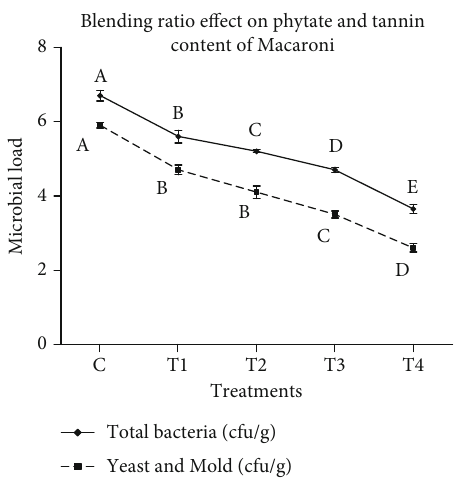
Figure 2: E ff ect of blending ratio on microbial load (total bacteria and mold and yeast) of wheat-moringa